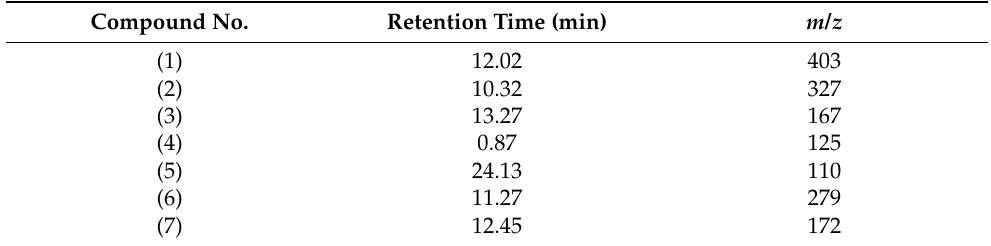
Table 3. Main intermediates from the degradation of rhodamine B and methyl orange detected by